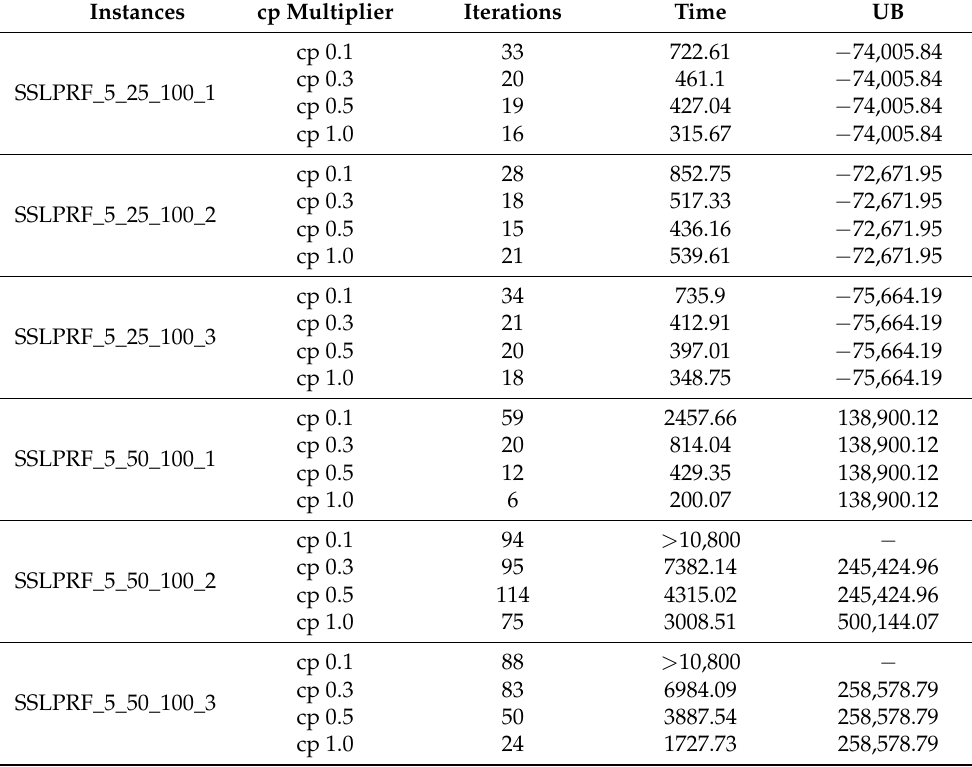
Table A2. Computational results for PySP on